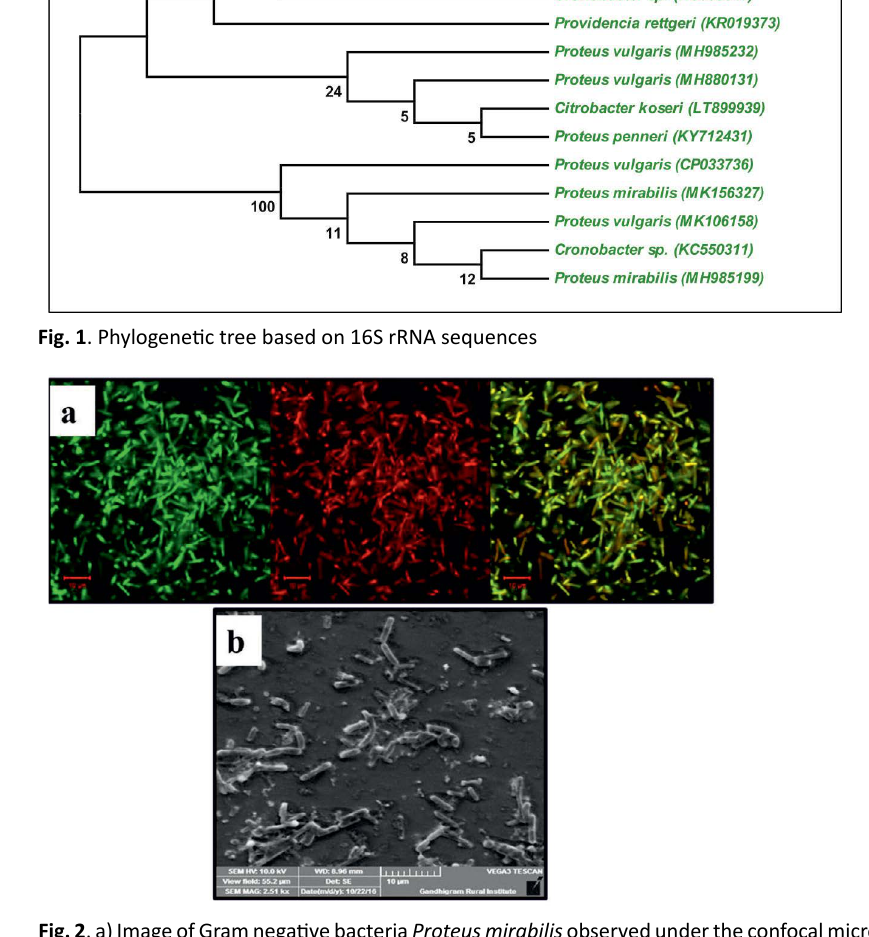
Fig. 2 . a) Image of Gram negative bacteria Proteus mirabilis observed under the confocal microscope; b) SEM image of Gram negative bacteria Proteus